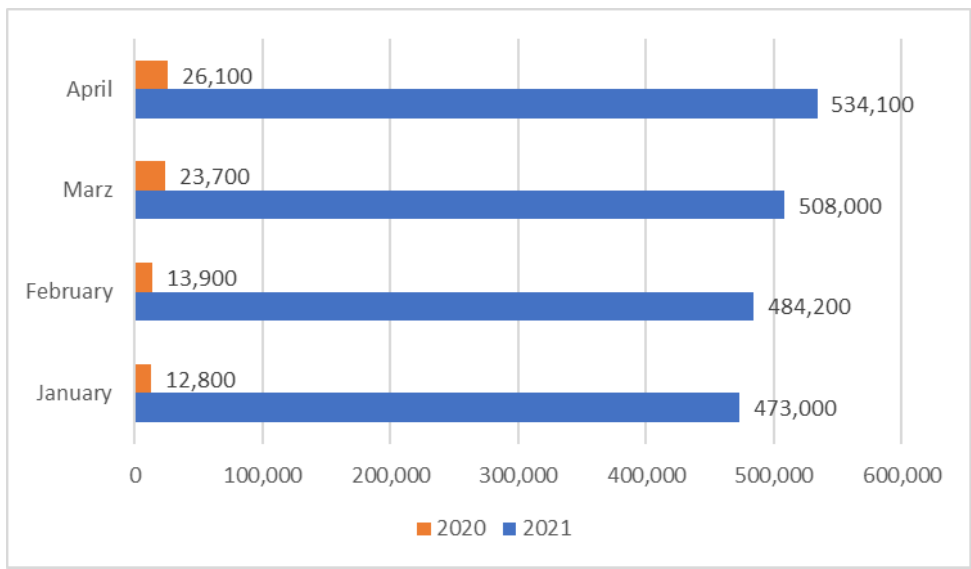
Figure 2. Increase in the number of PV installations on rooftops Source: Based on data from the Energy Market Agency (June 2021).